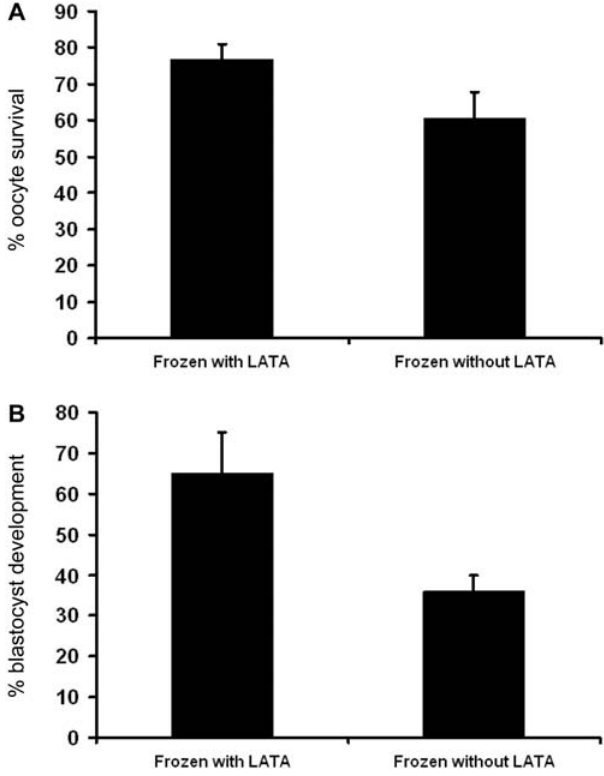
Figure 5. Oocyte survival after cryopreservation. (A) The percentage of mouse oocytes that survived slow-cooling with (left) and without (right) LATA pretreatment. LATA pretreatment increased the cryosurvival rate by 26.2% ( p , 0.05). (B) The percentage of blastocysts developed from 2-cell embryos with (left) and without (right) LATA pretreatment. LATA pretreatment increased developmental competence by 81% ( p , 0.05). Error bars represent the SEM. doi:10.1371/journal.pone.0002787.g005 deform the cytoskeleton. This elastic deformation continues until t < t , where the time scale t = m / k (another characteristic cytoplasmic quantity) is determined by both the viscous and elastic properties of the environment. During this time, bead displacement (proportional to1/ m+ 1/ m 1 ) is dominated by the Table 1). The origin of m is mostly in the viscous liquid properties of the cytoplasm (for fresh oocytes, the associated viscosity g < 10 2 1 Pa 6 s, is , 100 times larger than that of water), whereas the origin of k is in the elasticity of the cytoskeletal filaments. Once the cytoskeletal mesh is locally maximally stretched (i.e. t . m / k ), the bead’s total displacement is dominated by the combination of